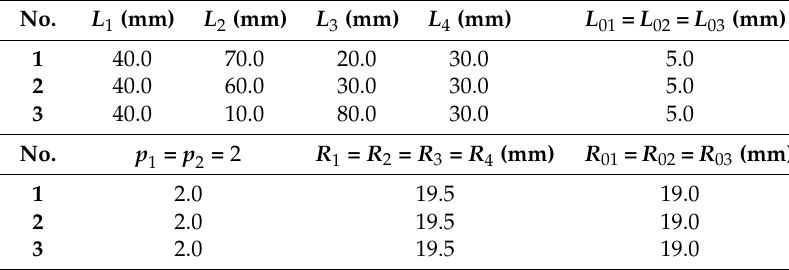
Table 1. Geometrical dimensions for the cascaded piezoelectric ultrasonic transducer.